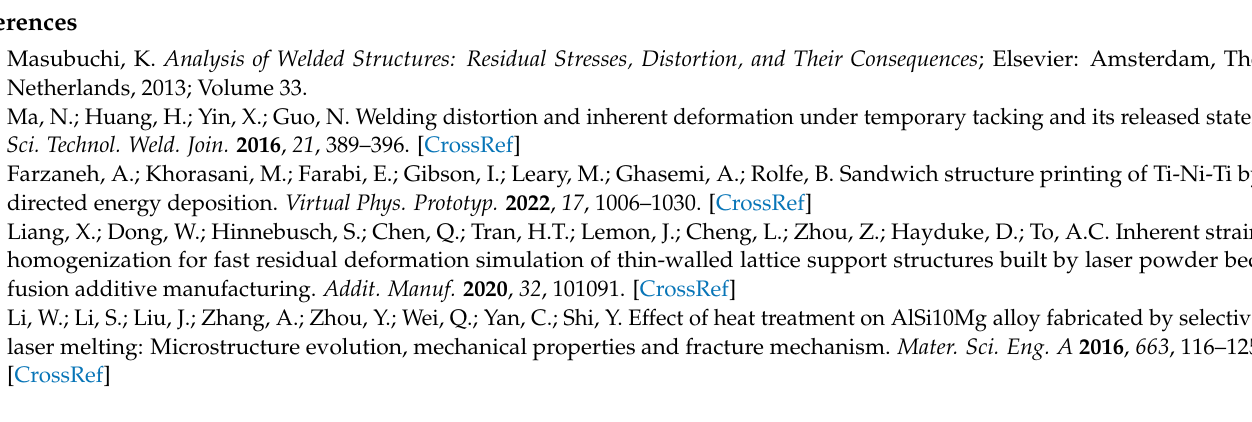
Figure 17. Weld deformation in the radial direction according to the circumferential direction at thickness 2.67 mm: ( a ) without jig; ( b ) with jig.